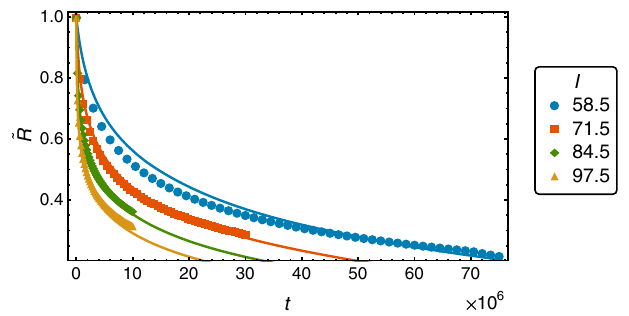
FIG. 9. Fitting results for the evolution of the normalized resistance according to Eq.